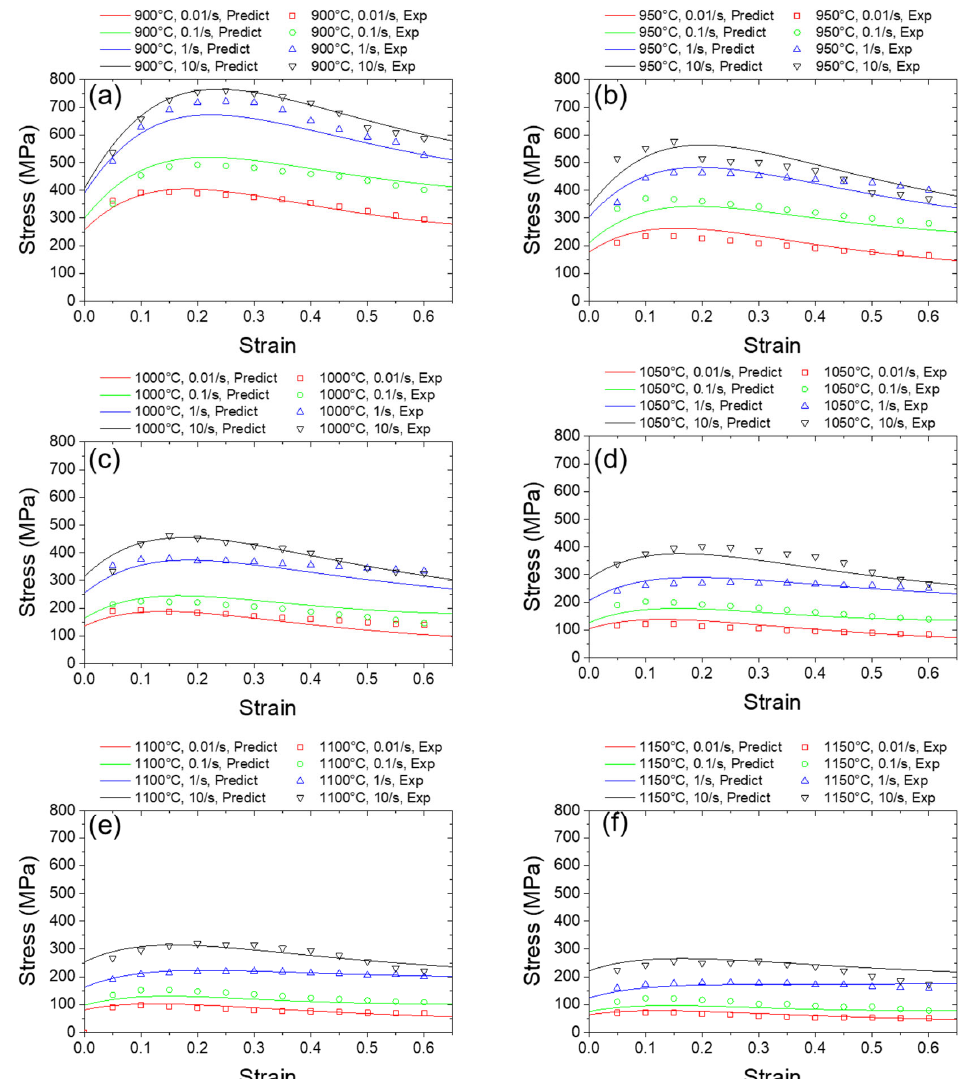
Figure 8. Predicted flow stress using the optimized ANN. ( a – f ) are the predicted stress-strain curves at 900 °C, 950 °C, 1000 °C, 1050 °C, 1100 °C and 1150 °C.